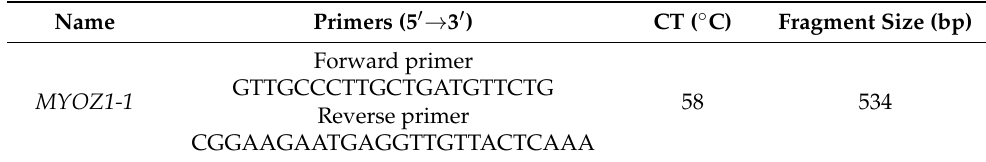
Table 2. PCR primer for SNP screening of duck